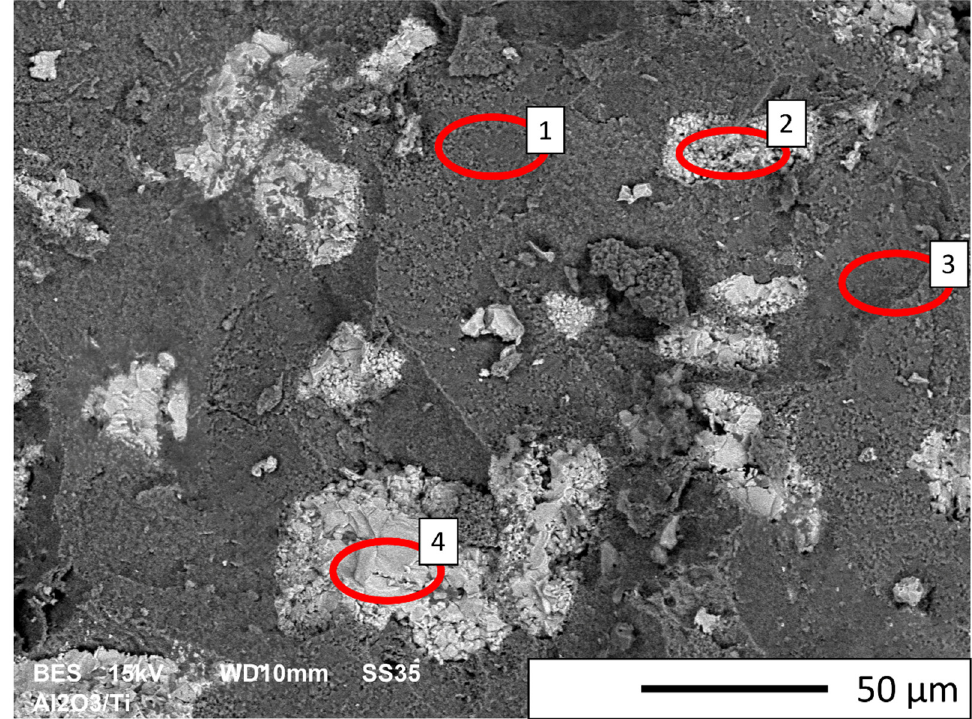
Figure 8. SEM image (BSE mode) of sintered Al 2 O 3 /Ti sample.